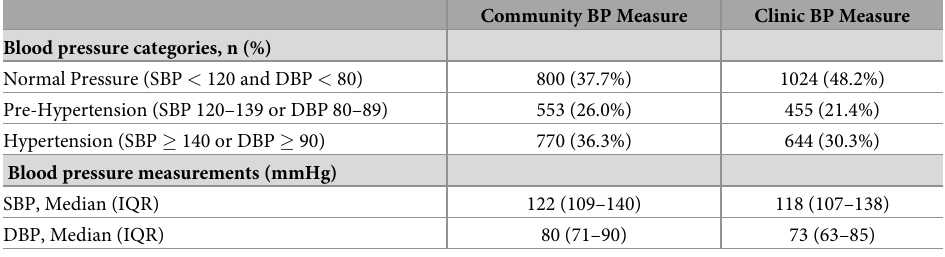
Table 2. Blood pressure measurements of participants in the Haiti CVD cohort study (N = 2123). Community BP Measure